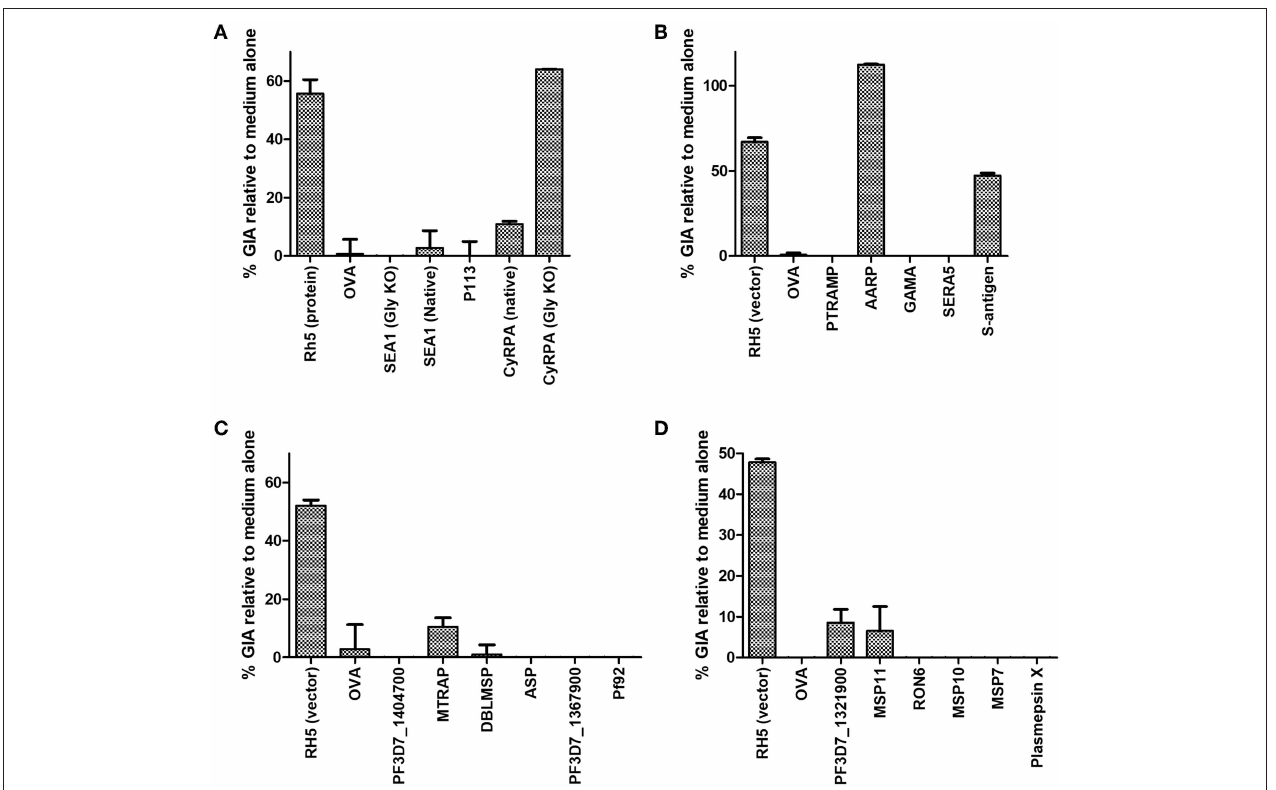
FIGURE 3 | Growth inhibitory activity of antibody specificities. The protein-G purified total IgG samples tested for schizont reactivity as shown in Figure 2 were screened for activity in the standardized assay of GIA at 1 mg/mL. Each of panels (A–D) represents IgG from one independent mouse immunization campaign. Samples were not subjected to pre-incubation with RBC prior to GIA testing. Data is shown as mean of triplicate wells of a single GIA assay, and are representative of two independent